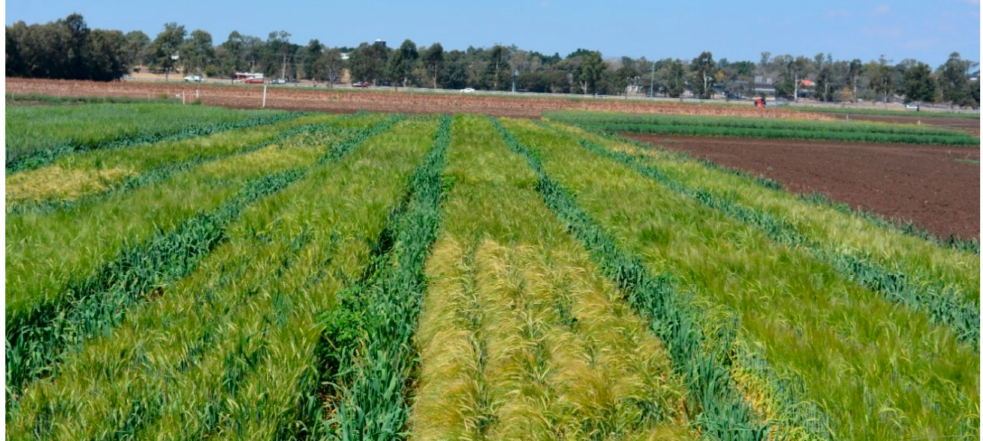
Figure 1. View of barley genotypes tested in the experimental